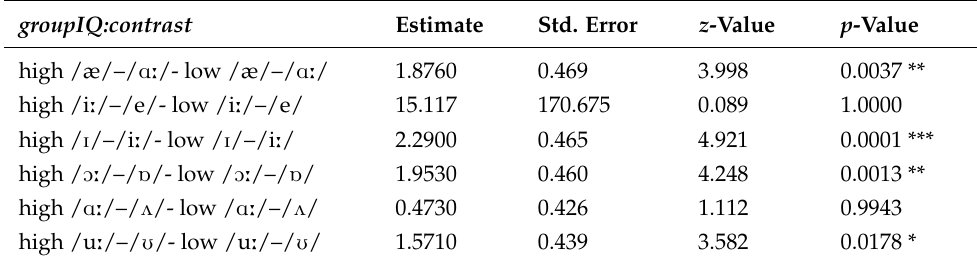
Table 2. Pairwise comparisons for groupIQ:contrast . groupIQ:contrast Estimate Std.